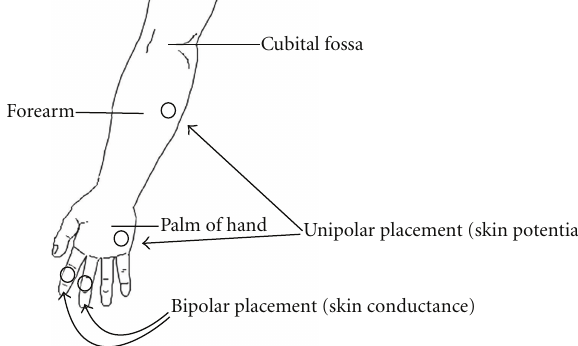
Figure 4: Suggested electrode sites on the palm for the measure- ment of skin resistance and skin potentials; redrawn from